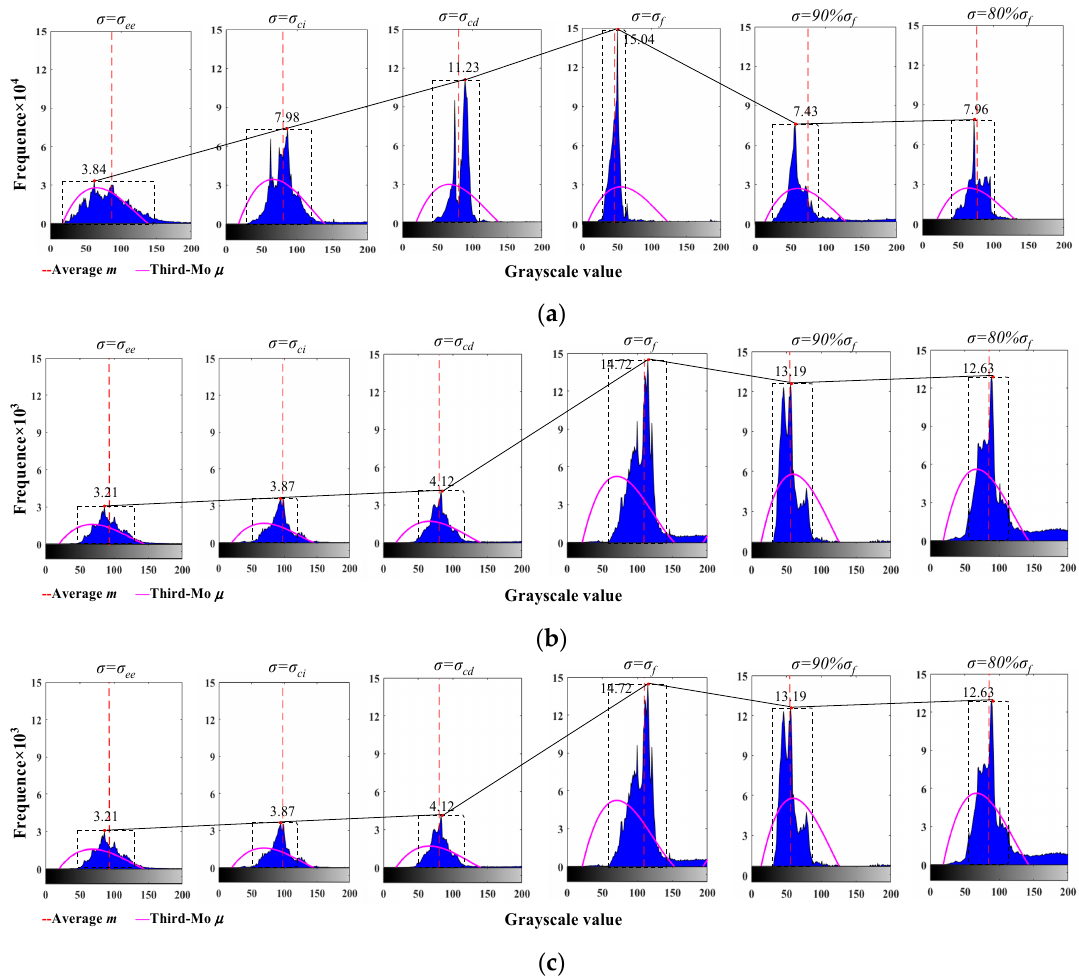
Figure 5. Grayscale histogram of the failure process of the specimen. ( a ) HS-0%. ( b ) HS-20%. ( c ) HS- 40%. ( c ) HS-40%. 2 (cid:13) When the stress is between σ cd and σ f , the peak grayness values of the